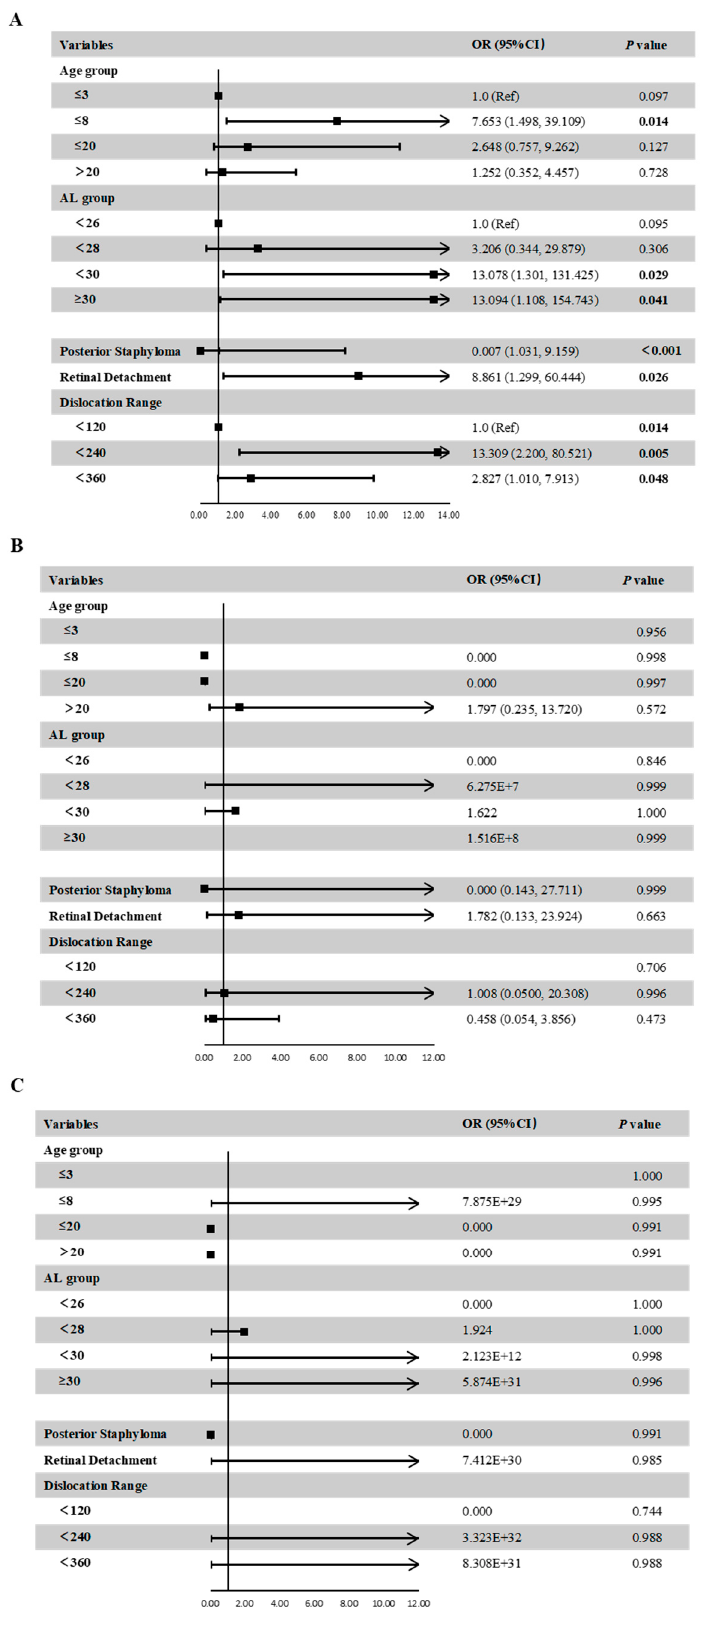
Figure 5. Associations between ocular parameters and the presence of atrophic maculopathy ( A ), tractional maculopathy ( B ), or neovascular maculopathy ( C ) in the multivariate adjusted models.